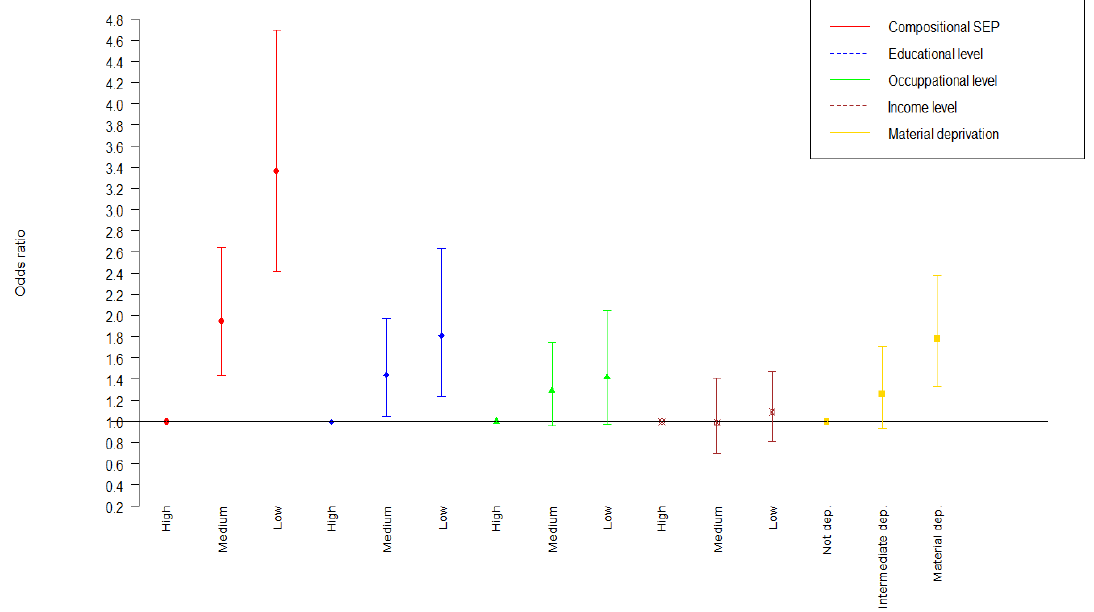
Figure 1. Odds ratios of compositional SEP and separate SEP measures in relation to type 2 diabetes mellitus (T2DM), adjusted for sex, age, early life SEP and verbal intelligence.